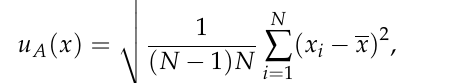
Figure 8. SEM images of the structure after annealing in 50 µm ( a ) and 3 µm ( b ) resolution.